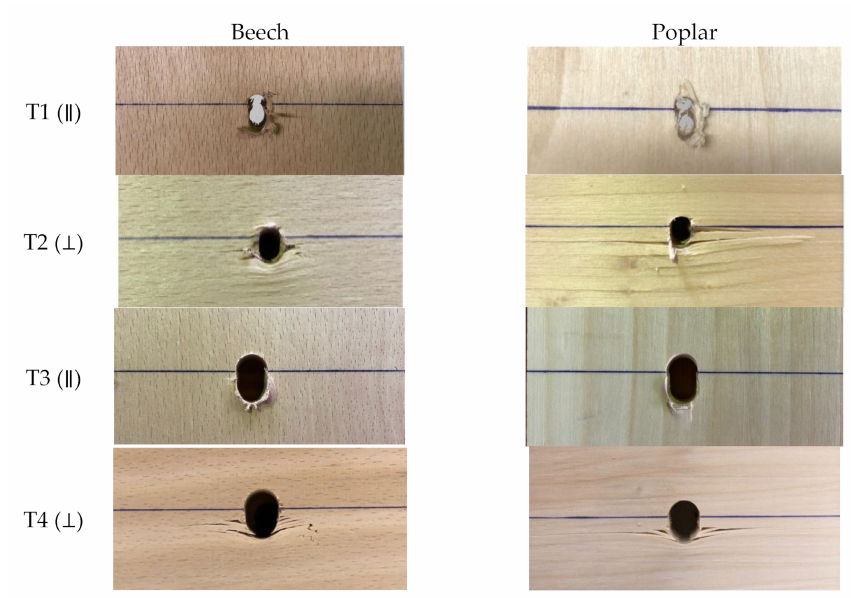
Figure 10. Failure modes per species for different tests: (T1) screw ø 9 mm; (T2) screw ø 9 mm; (T3) bolt ø 12 mm; (T4) bolt ø 12